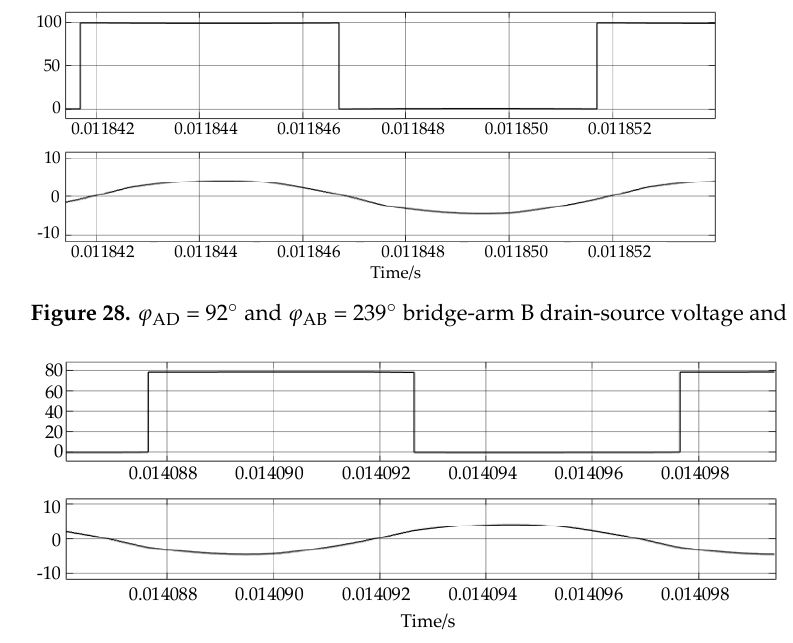
Figure 29. φ AD = 92° and φ AB = 239° bridge-arm C drain-source voltage and current waveforms.